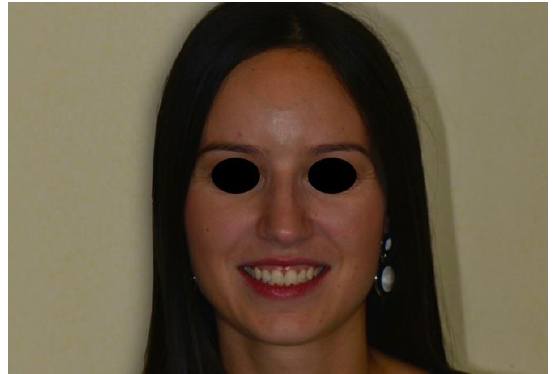
Figure 12. Post-operative full-face view. Dent. J. 2019 , 7 , x FOR PEER REVIEW